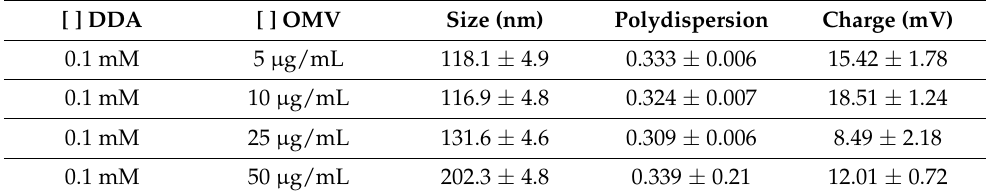
Table 2. Physical properties of DDA complexed to different concentrations of N. meningitidis OMVs.